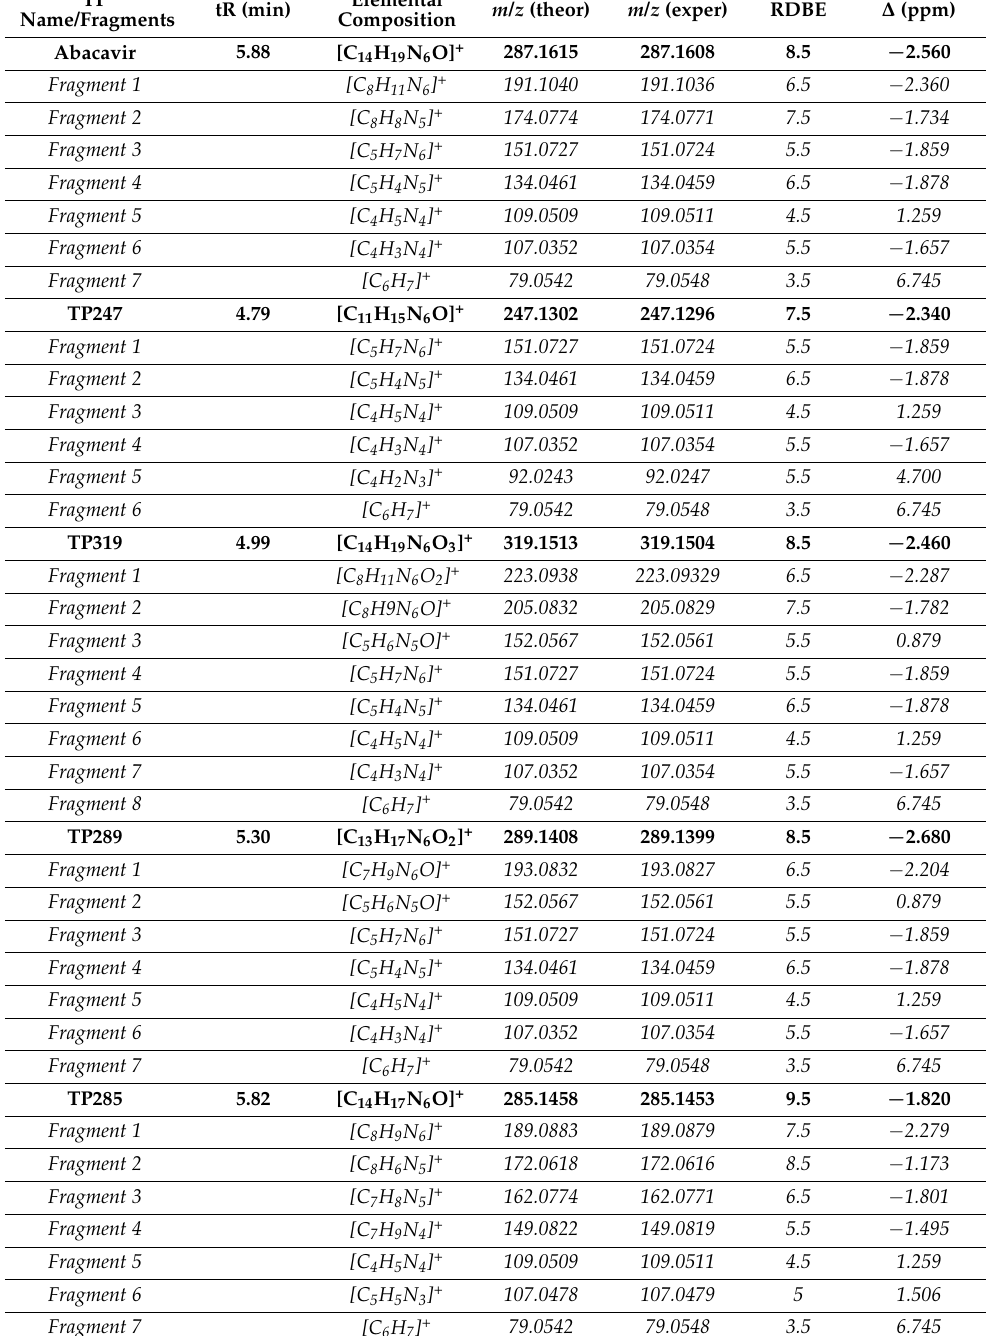
Table 1. LC–HRMS for the major TPs of